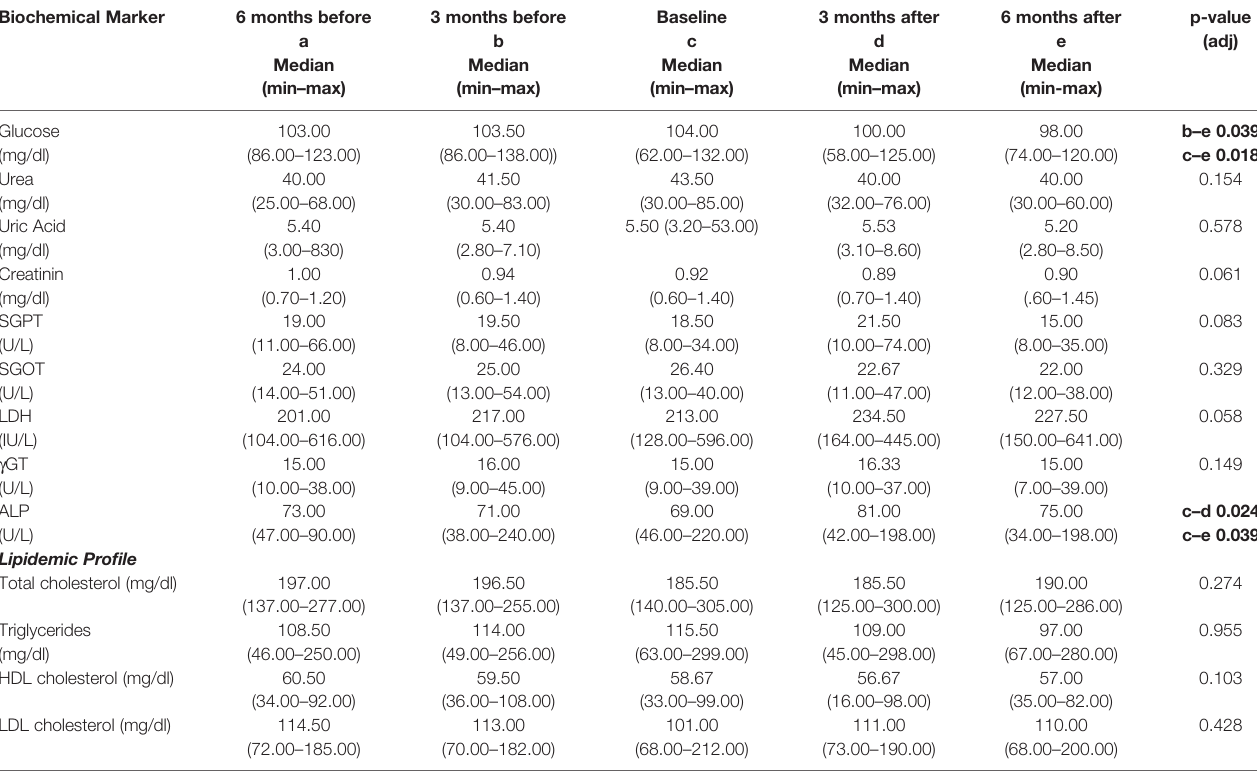
TABLE 3 | Differences in biochemical markers of patients with CLL (N = 22) before and during the DI2 with High OC/OL - EVOO. a